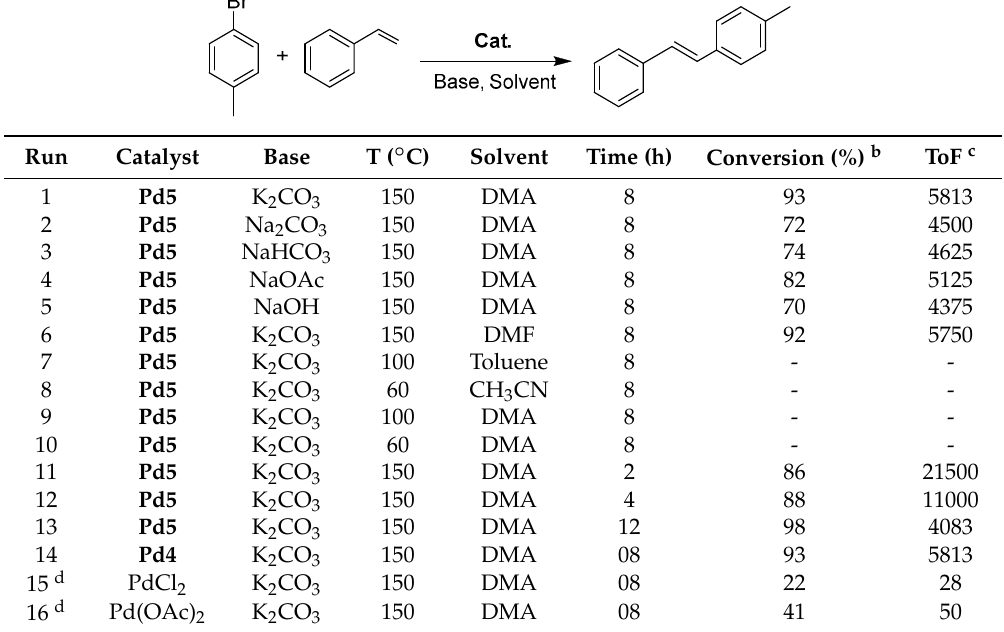
Table 3. Optimization of reaction conditions using Pd1 as catalyst a .